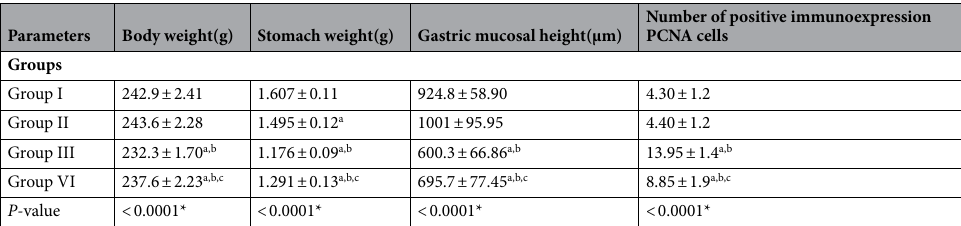
Table 1. Final body and stomach weights, gastric mucosal heights, and numbers of positive immunoexpression PCNA cells of the studied groups. Data are represented as Mean ± SD (n = 20) *means statistically significant difference. a Statistically significant as compared with group I, P < 0.05. b Statistically significant as compared with group II, P < 0.05. c Statistically significant as compared with group III, P <